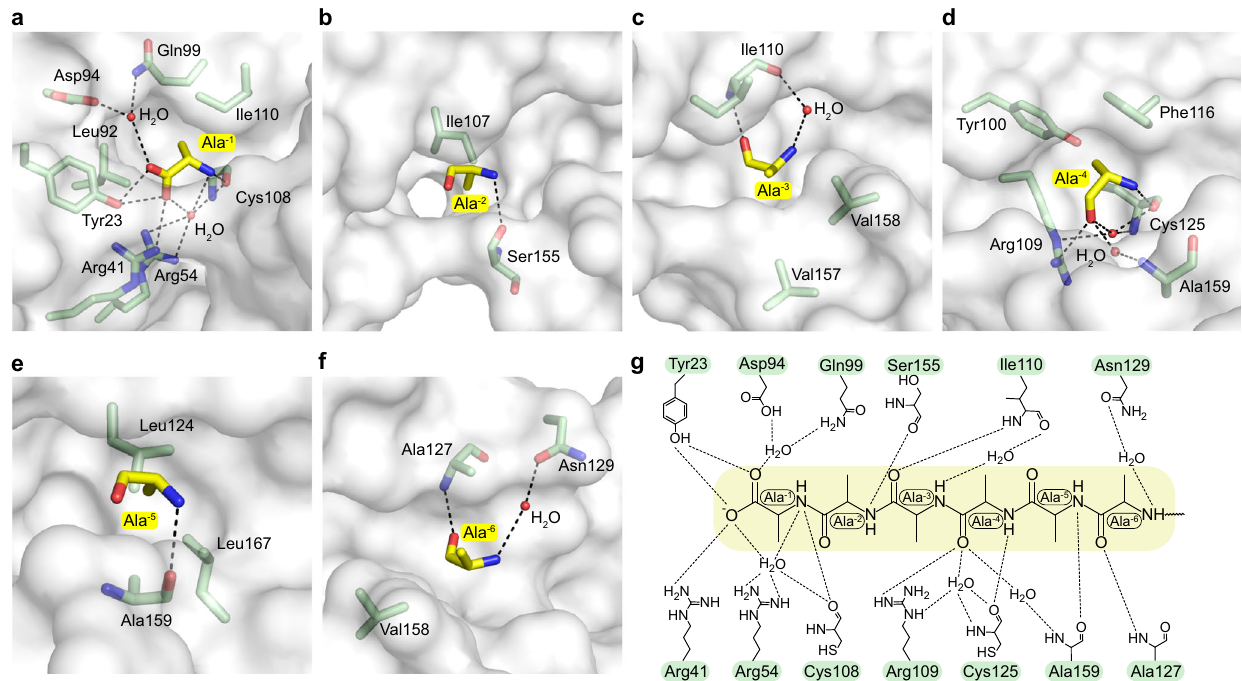
Fig.3|MolecularbasisofAla6/C-degronrecognitionbyPirh2.a – f Close-upview of the interactions of Pirh2 with Ala-1 to Ala-6 in the binding groove. Alanine resi- dues of Ala6/C-degron are shown as yellow sticks; residues of Pirh2 that are